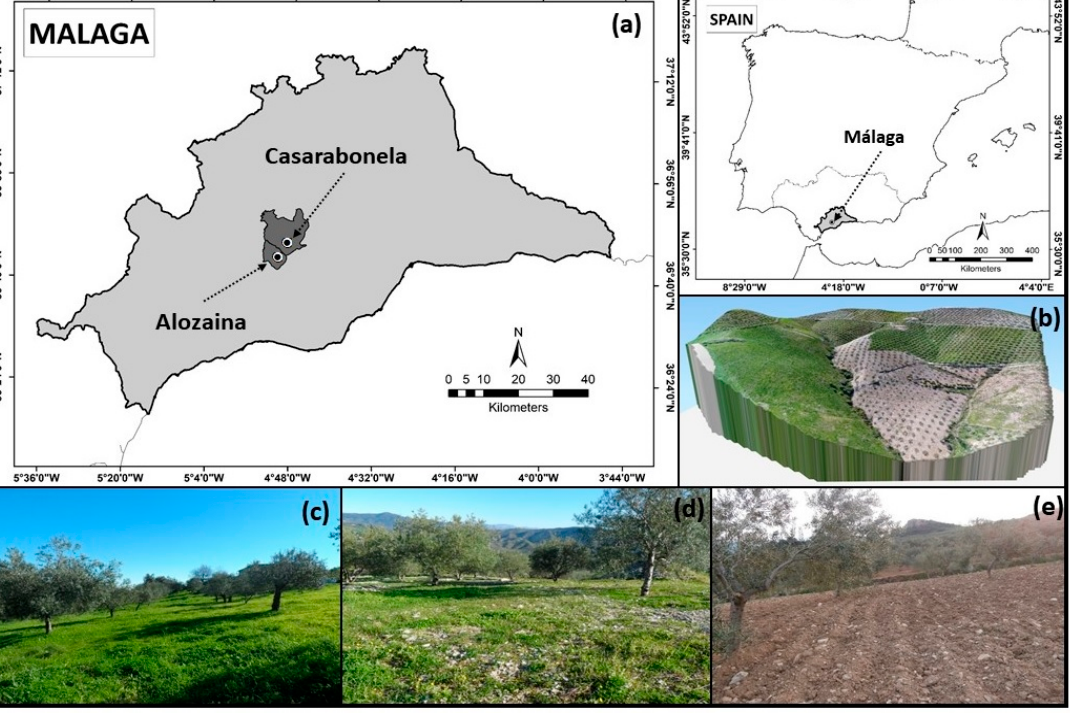
Figure 1. Study area: ( a ) location in the province of Malaga; ( b ) undulating relief and geometric planting framework; ( c ) areas with high VGC density; ( d ) areas with medium VGC density; and ( e ) no VGC (bare soil).